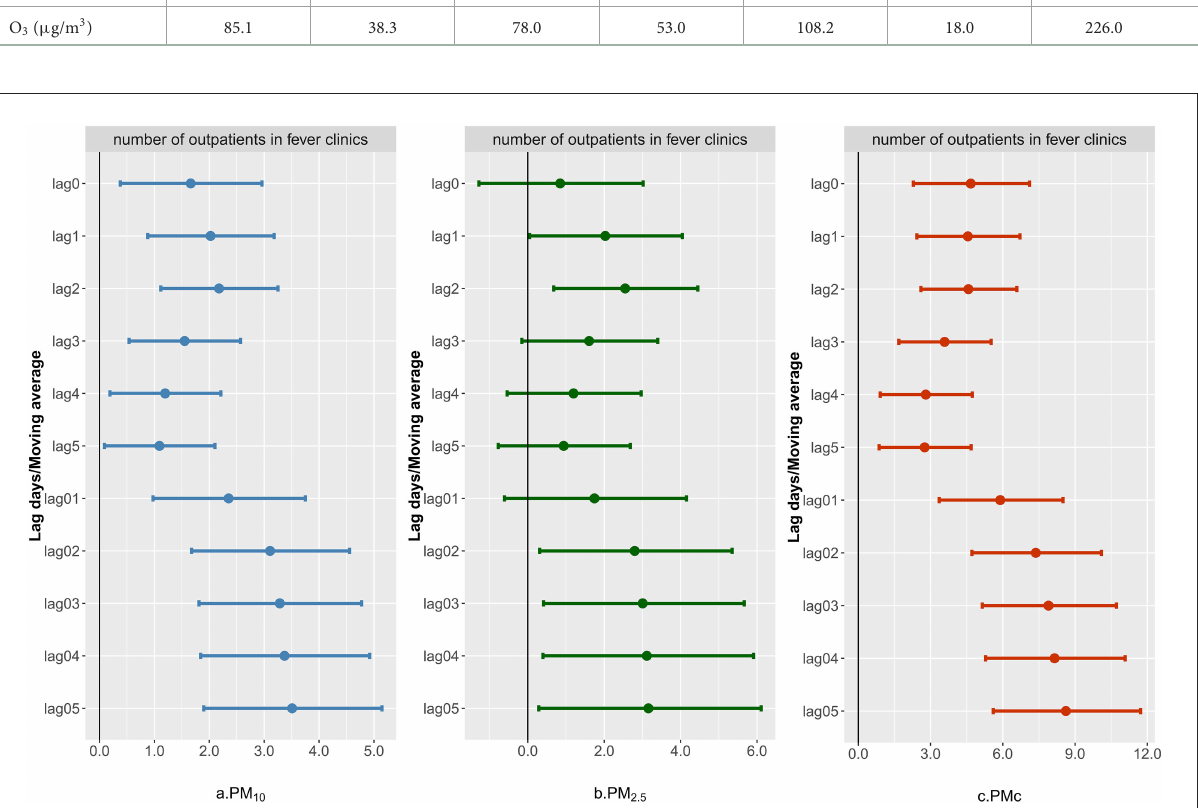
FIGURE1 Excess risk of number of outpatient visits to fever clinics for each 10 µ g / m 3 increase in PM 10 , PM 2.5 , and PMc. The ER and corresponding 95% CI were derived from an over-dispersed generalized additive model, with calendar time, weather conditions, day of the week (DOW), and public holiday (PH)